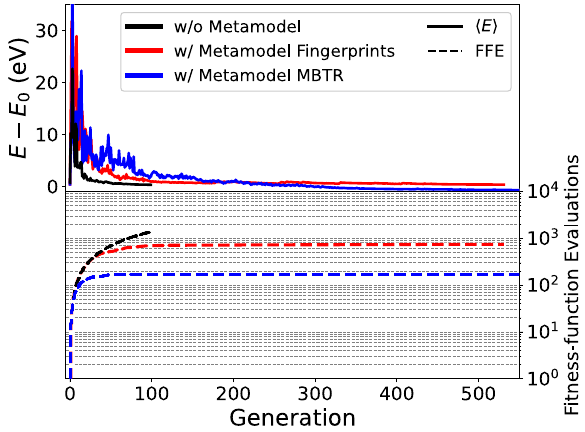
Fig. 7 Reducing computational costs using the ML metamodel. Comparison between two types of runs of the EA for the Si i defect. One type employs only DFT calculations (black lines) and one is performed with the use of the machine learning metamodel, emyploying either the crystal fi ngerprints descriptors (red lines) or the MBTR ones (blue lines). Dashed lines represent the number of required fi tness-function evaluations. The bold lines, the population average energy referenced to the ground state energy of Si i obtained in LDA